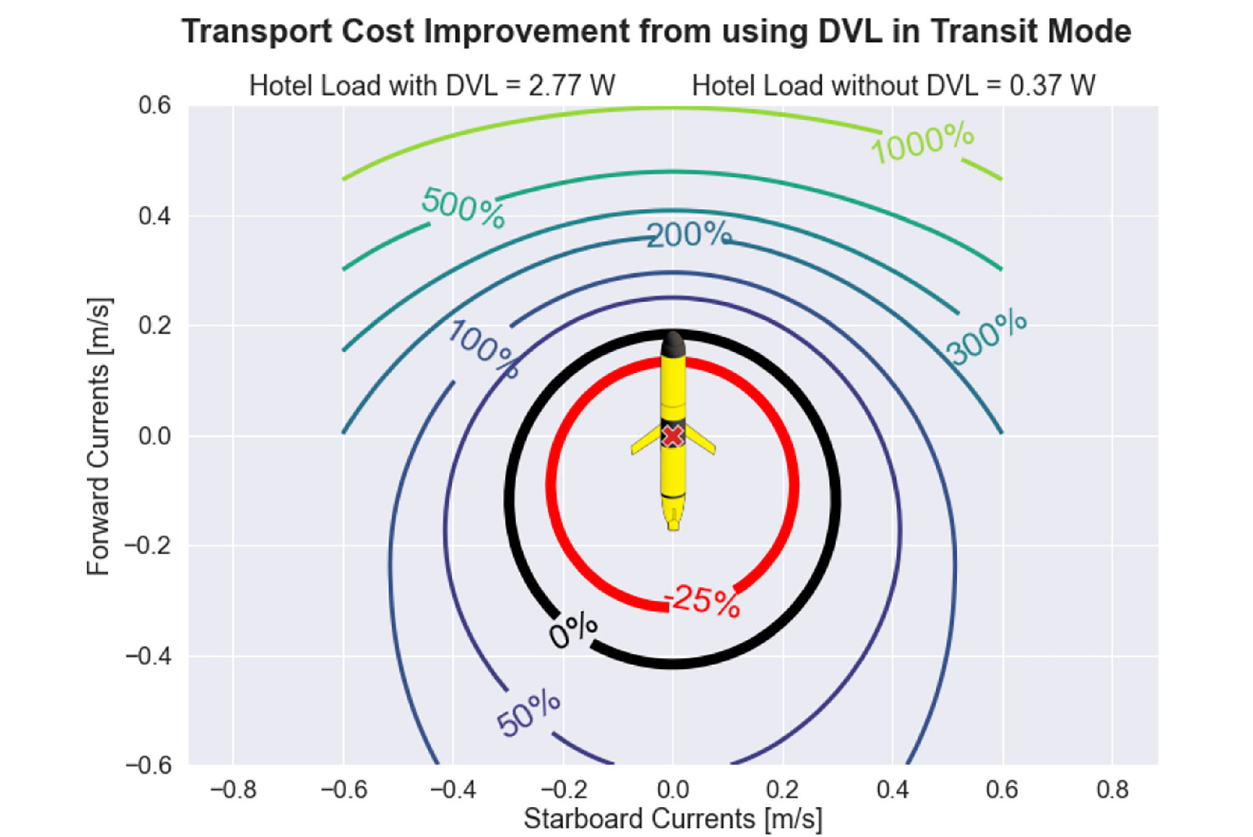
FIGURE 6 | Transport cost improvement obtained by operating the Doppler velocity log (DVL) while transiting. By operating the DVL during transit, the autonomous underwater glider (AUG) can perform adaptive velocity control (AVC), which includes active steering to avoid cross-track and long-track drift caused by ocean currents and active throttling to take advantage of environmental conditions. The downside of operating the DVL is that the glider hotel load is increased. Thus, for ocean currents of small magnitudes, transport cost is actually worsened when the DVL is operated during transit, but for ocean currents of moderate magnitudes, transport cost can be substantially